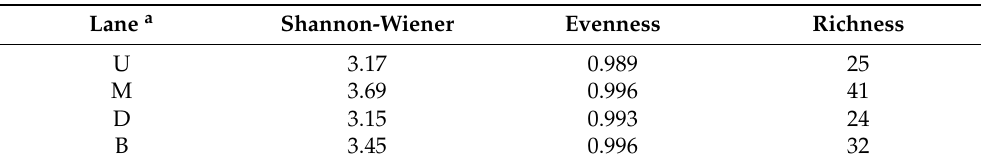
a Lanes U, M, D, and B respectively represent pit mud samples collected from the up wall layer of the cellar, middle wall layer of the cellar, down wall layer of the cellar, and bottom layer of the cellar, and were sampled from the same fermentation